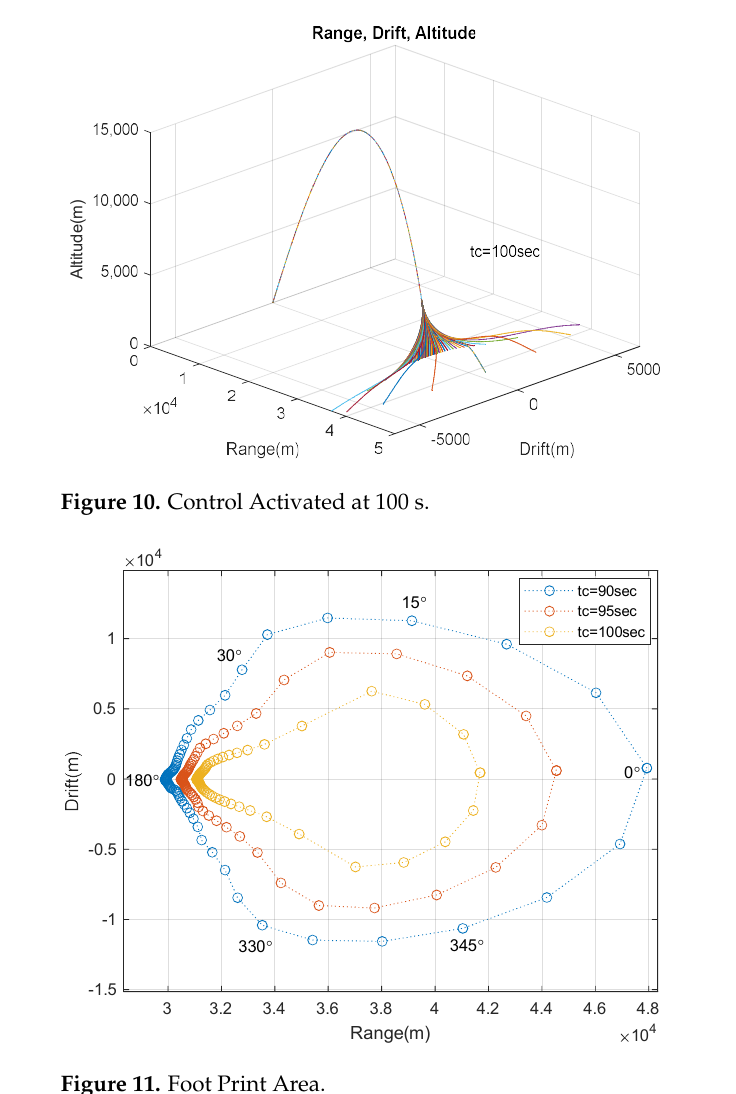
Figure 9. Control Activated at 95 s.